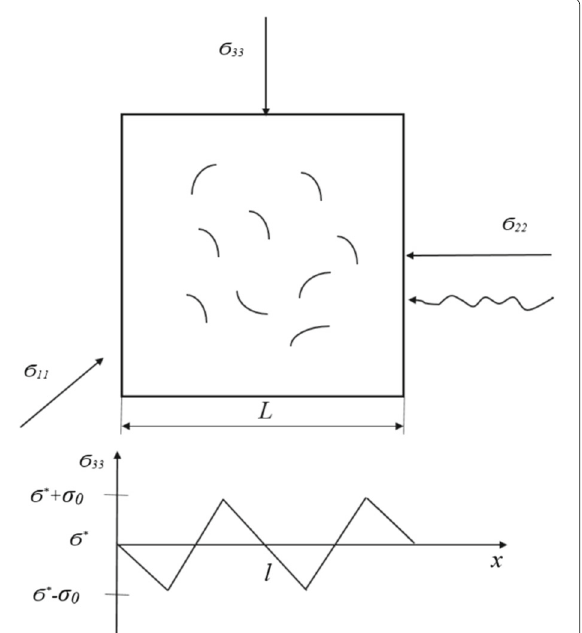
Fig. 2 Graphical statement of a problem